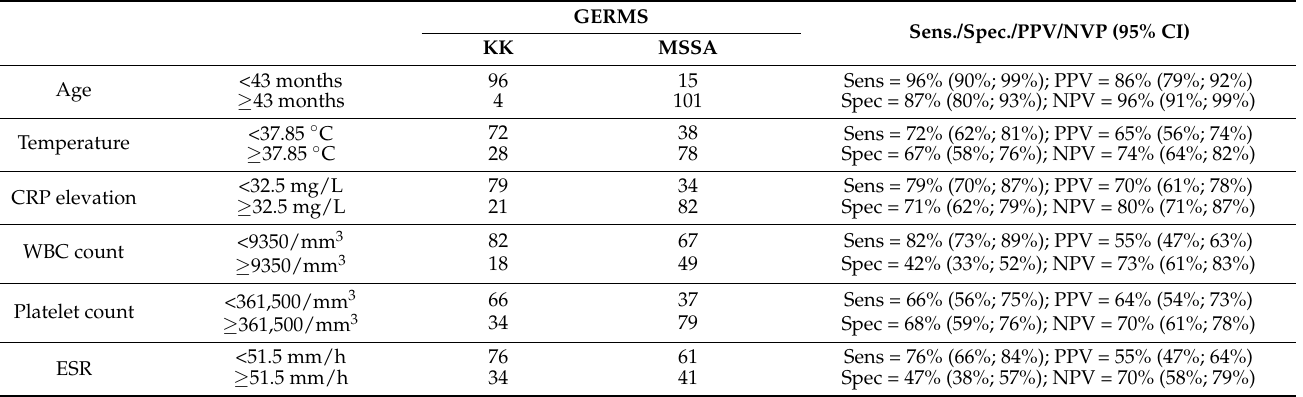
Table 2. Diagnostic ability of optimum cut-offs to discriminate between patients with S. aureus and K. kingae